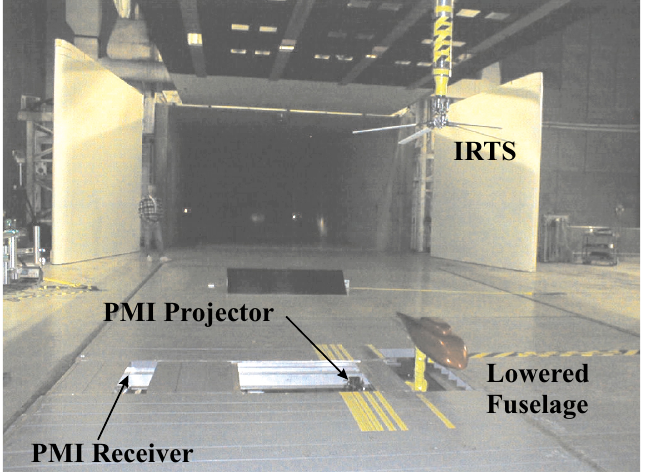
Fig. 5. PMI system installed in the 14-By 22-Foot Subsonic Tunnel for the Rotor Wake / Configuration Aerodynamics